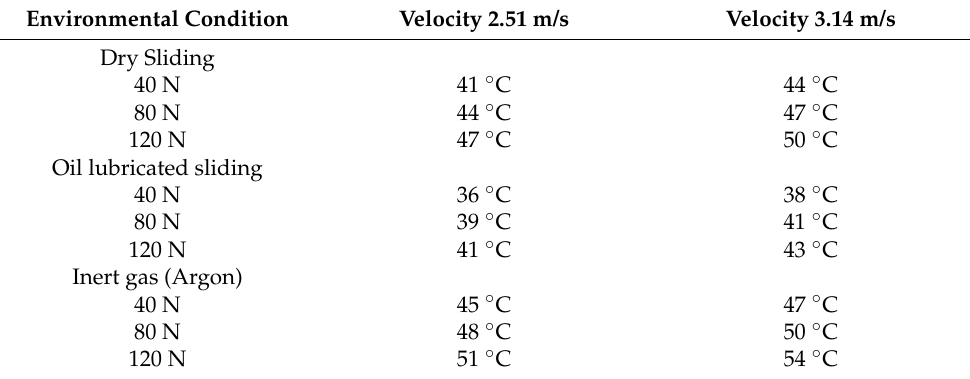
Figure 1. ( a ) Vacuum bagging setup used for fabrication of laminates and ( b ) fabricated pin samples ( c ) pin geometry. Table 1. Variation of the temperature (°C) for CNT filled GFRP composite samples at different loads/sliding velocity and environmental conditions.